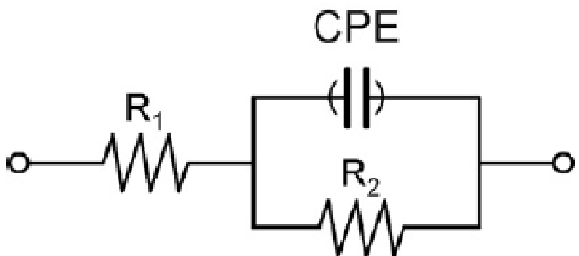
Figure 2. Equivalent circuit used for the data fitting. R is the electron-transfer resistance and CPE, the capacitive contribution, in this case as